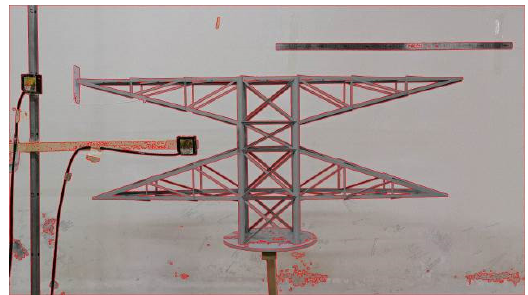
Figure 1. Result of contour identification.